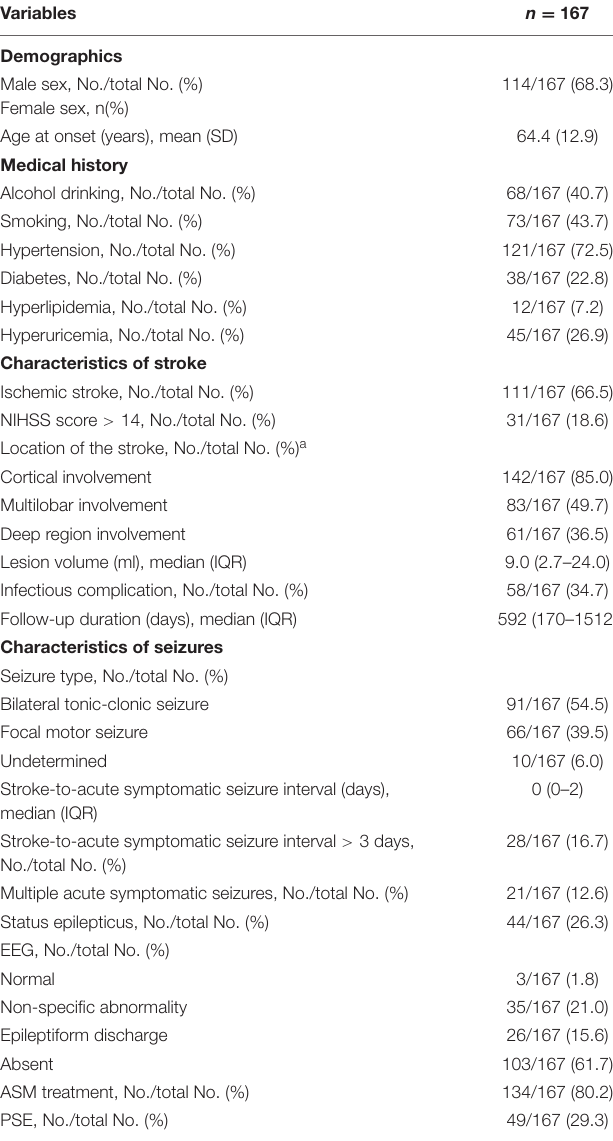
TABLE 2 | Baseline characteristics of the total